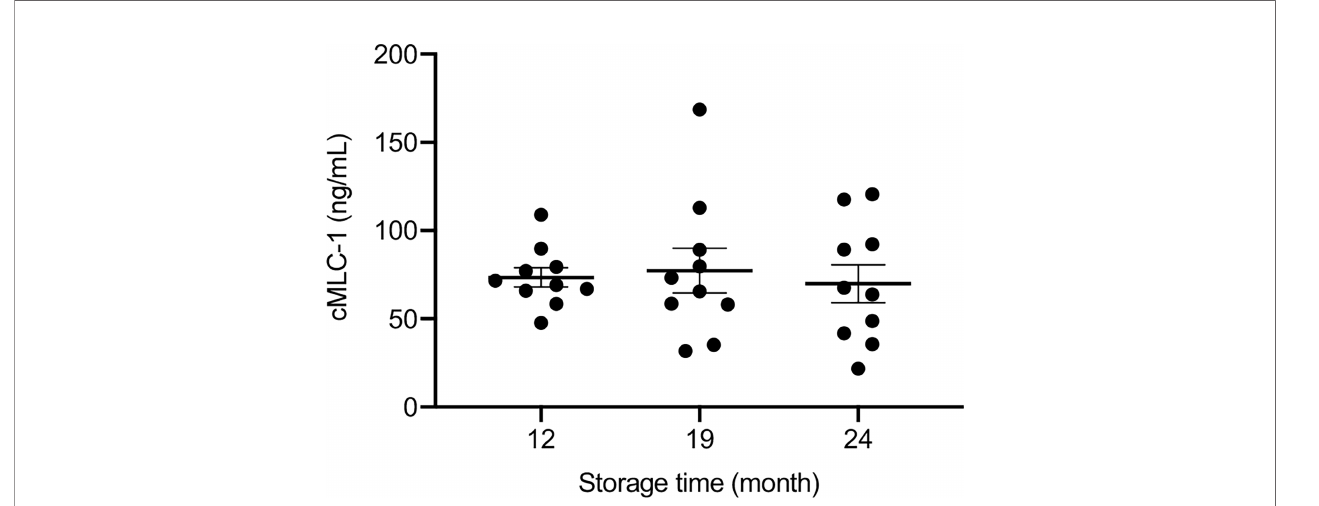
FIGURE 6 | Stability of cMCL-1 in plasma stored at -80°C. Plasma cMLC-1 levels were repeatedly tested in samples from breast cancer patients and normal donors. Representative data using the same set of normal donors samples (n=10) stored at -80°C for 12, 19 and 24 months are shown. The one-way ANOVA was used to test the difference ( p